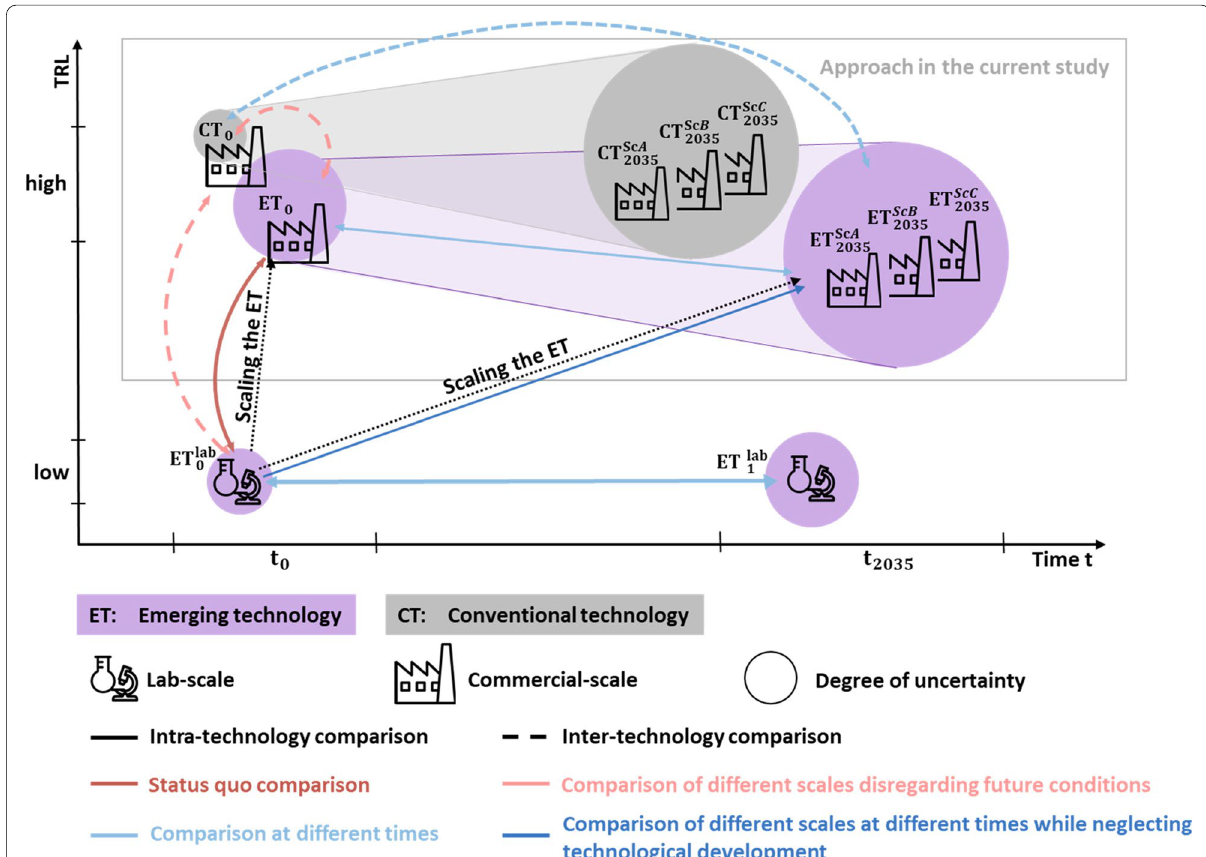
Fig. 1 Location of the approach used within this study based on the general framework of Thonemann et al. [33] (source: Own presentation based on the work of Thonemann et al.